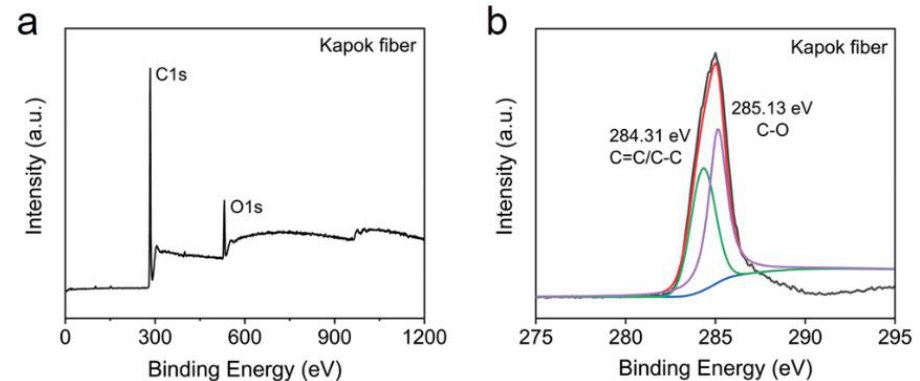
Figure 3. ( a ) XPS spectra of kapok fiber and ( b ) XPS region of kapok fiber that is related to C1s [49]. Reprinted (adapted) with permission from Song, P.; Cui, J.; Di, J.; Liu, D.; Xu, M.; Tang, B.; Zeng, Q.; Xiong, J.; Wang, C.; He, Q.; et al., Carbon Microtube Aerogel Derived from Kapok Fiber: An Efficient and Recyclable Sorbent for Oils and Organic Solvents. ACS Nano, 14, 595 – 602, Copyright 2020 American Chemical Society.